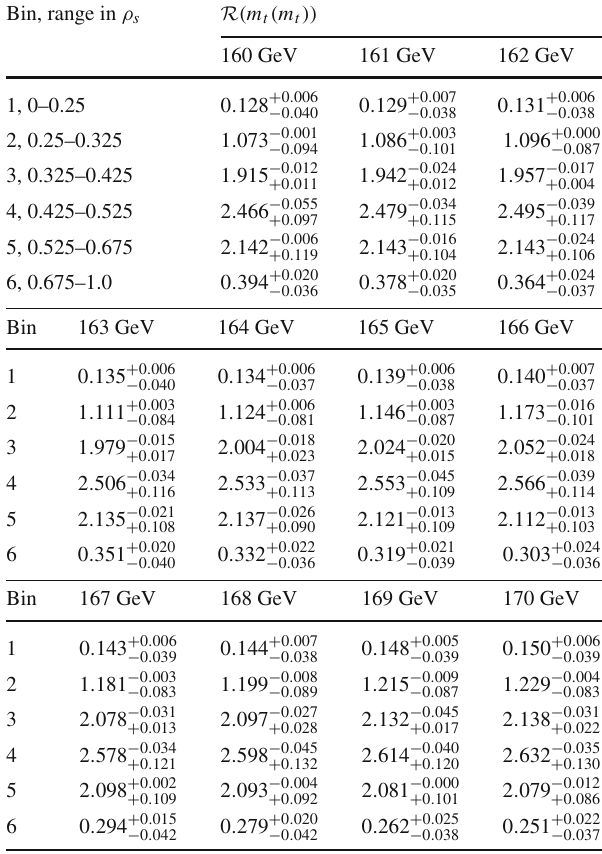
Table 1 The R ( m t ( m t )) -distribution calculated using t ¯ t + 1 -jet sam- ples at NLO accuracy for different m t ( m t ) values for the CT10 PDF set. The predictions for μ = m t are quoted as central values. The shifts the results for x = 2 m t and x = m t / 2 are quoted as upper-scripts